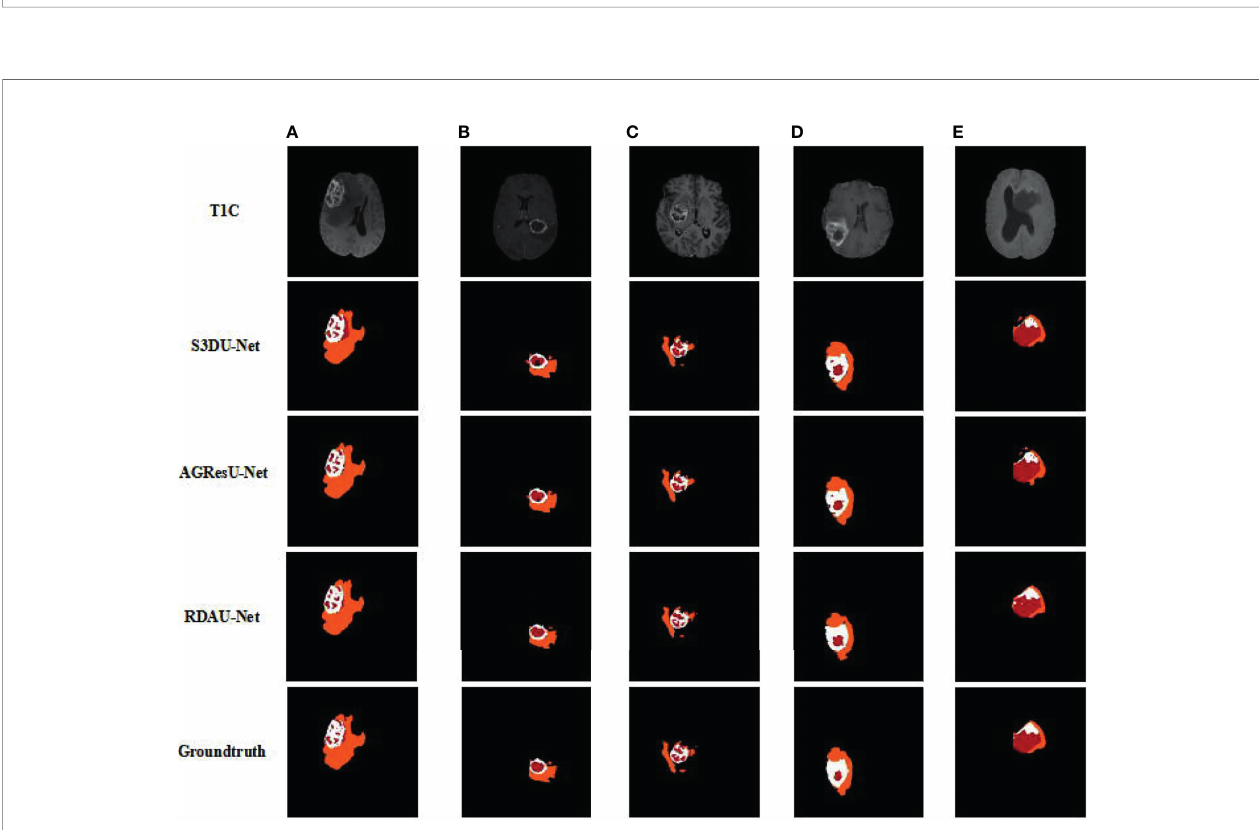
FIGURE 8 | Results of brain tumor segmentation in MRI images using the proposed approach and the ground truths. Columns (A – E) correspond to cases in the Brats 2018 challenge dataset: Brats18_2013_12_1_89, Brats18_CBICA_AQV_1_87, Brats18_TCIA02_117_1_69, Brats18_TCIA04_361_1_90, and Brats18_TCIA05_444_1_84, where 89, 87, 69, 90, and 84 represent the 89th, 87th, 69th, 90th, and 84th slices, respectively, of the MRI data. The colors represent the following categories: edema, necrosis, and □ enhancing